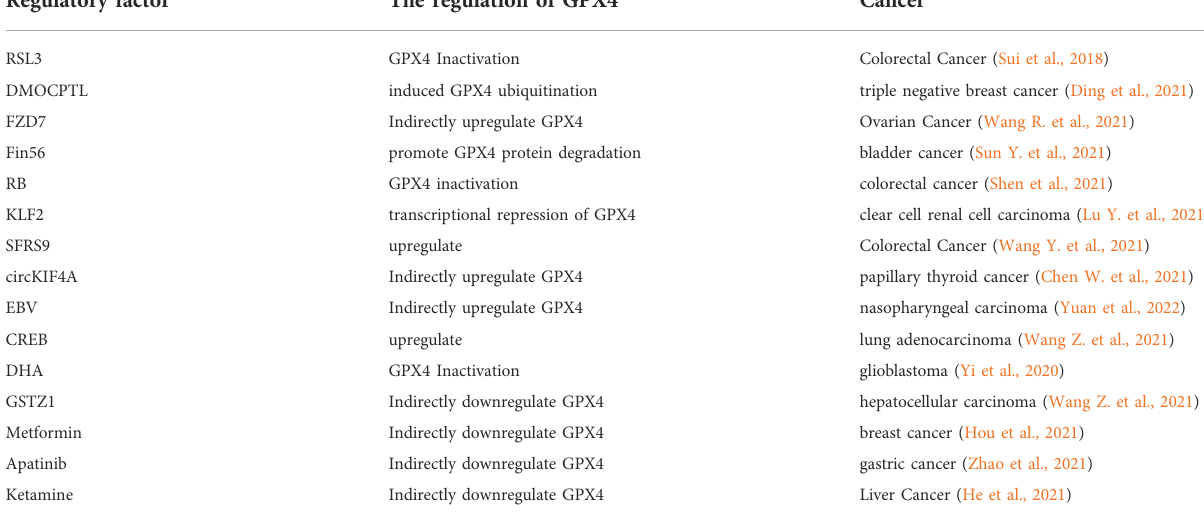
TABLE 3 Regulatory factors of